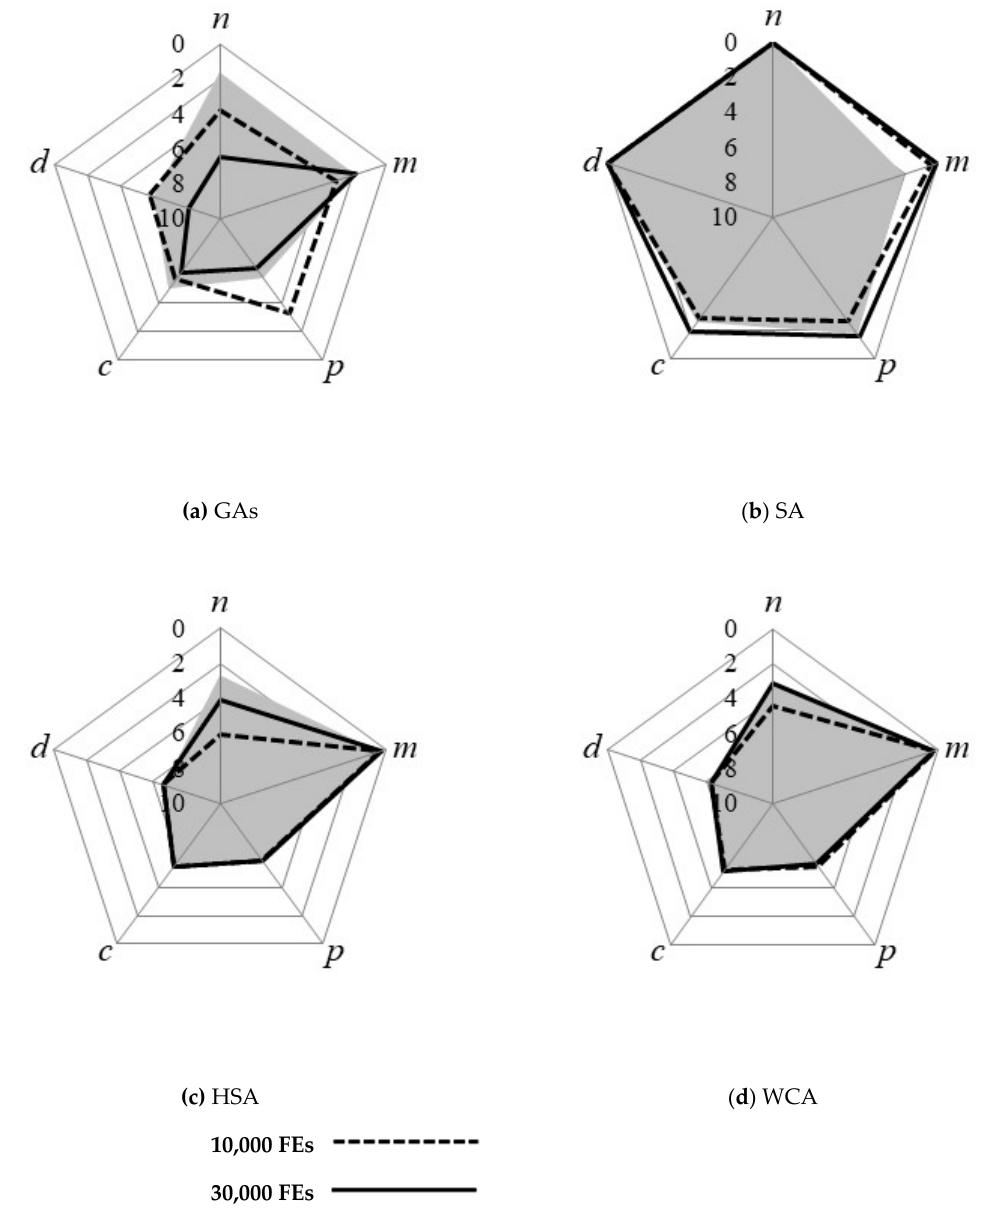
Figure 4. Performance comparison results (standard deviation of average improvement ratio). ( a ) GAs; ( b ) SA; ( c ) HSA; and ( d ) WCA.